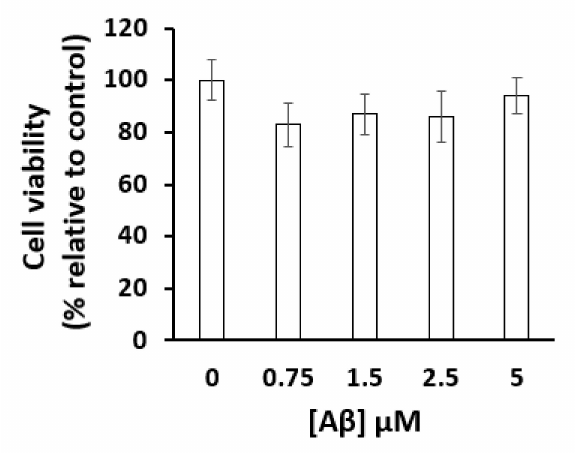
Figure 6. The cell viability of mature CGN was not significantly affected by A β (1–42) at the concen- trations tested (0.75–5 µ M) after 48 h of incubation at 37 ◦ C and 5%CO 2 . Cell viability was measured using the 3-(4,5-dimethylthiazol-2-yl)-2,5-diphenyltetrazolium bromide (MTT) assay as indicated in the Materials and Methods section. The results were the average ± s.e. of experiments done in triplicate, with two different preparations of